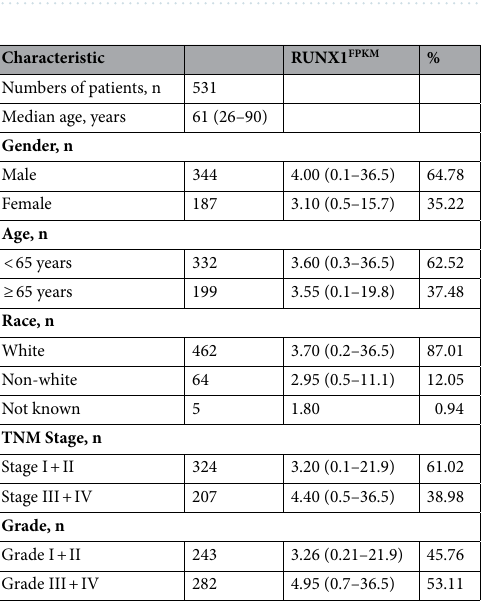
Table 2. The clinical characteristics about RUNX1 expression in KIRC patients. FPKM Fragments per Kilobase